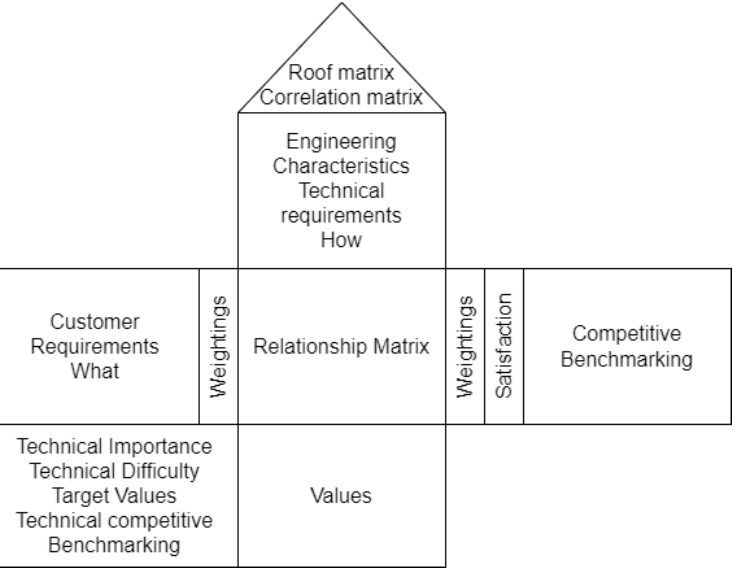
Figure 2. Conceptual house of quality [13,14].